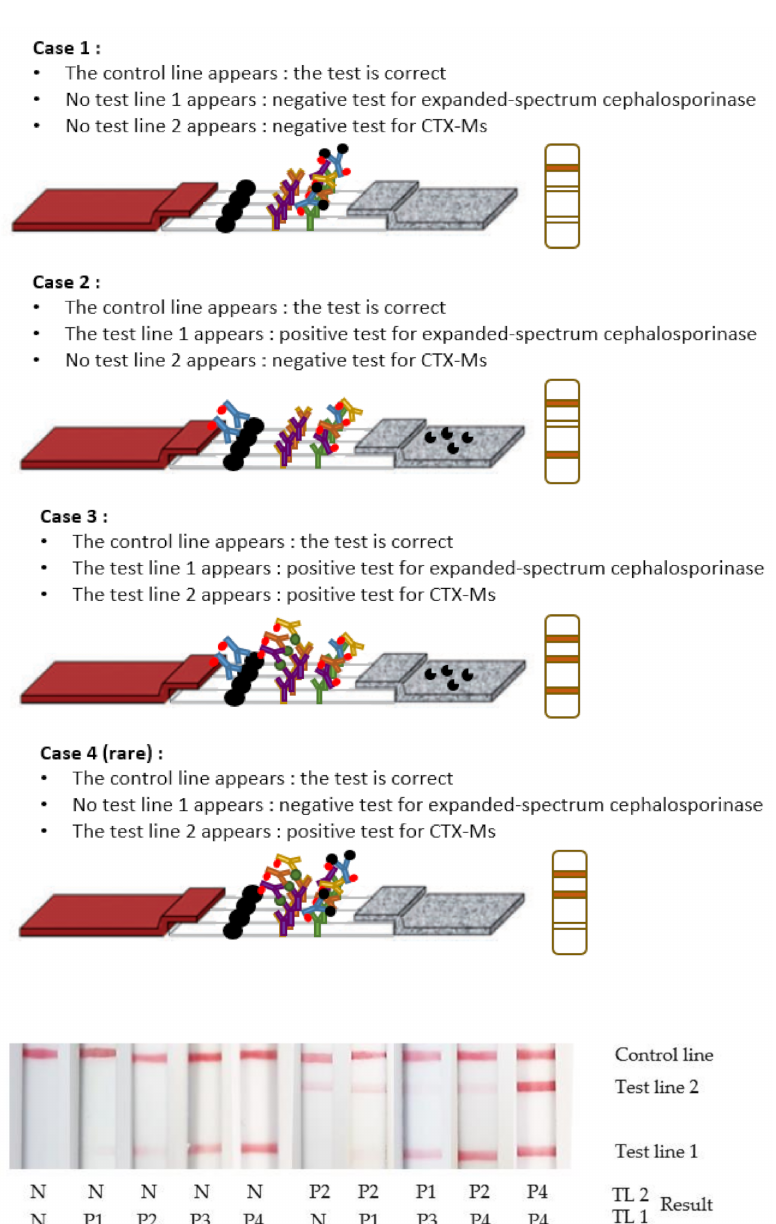
Figure 3. Test interpretation. Case 1: In the absence of enzymatic activity, all the anti-cefotaxime mAb’s paratopes are occupied by the CTX added to the sample before the test. On both tests lines, the results are negative: “N”. The control line is positive: “P”. Case 2: In the presence of enzymatic activity other than CTX-Ms, the hydrolysed CTX is not recognized by the anti-cefotaxime mAbs, which are able to react with the CTX immobilized on the Test Line 1. A signal appears only on the Test Line 1 and the control line “P”, when cephalosporinase expressing strains, other than CTX-Ms, are present. Case 3: In the presence of CTX-Ms, the hydrolysed CTX is not recognized by the anti- cefotaxime mAbs, which are able to react with the CTX immobilized on the Test Line 1. The labelled anti-CTX-Ms mAbs fix CTX-Ms and react with the anti-CTX-Ms mAbs on the Test Line 2. A signal appears on the Test Line 1, the Test Line 2 and the control line “P”. Case 4: In rare cases with some cephalosporinase-expressing strains such as CTX-M-93, the CTX is not hydrolysed. All the paratopes labelled anti-CTX-Ms mAbs fix CTX-Ms and react with the mAbs on the Test Line 2. A signal appears only on the Test Line 2 and the control line “P”. The associated number of “P” is relative to the intensities observed on the test